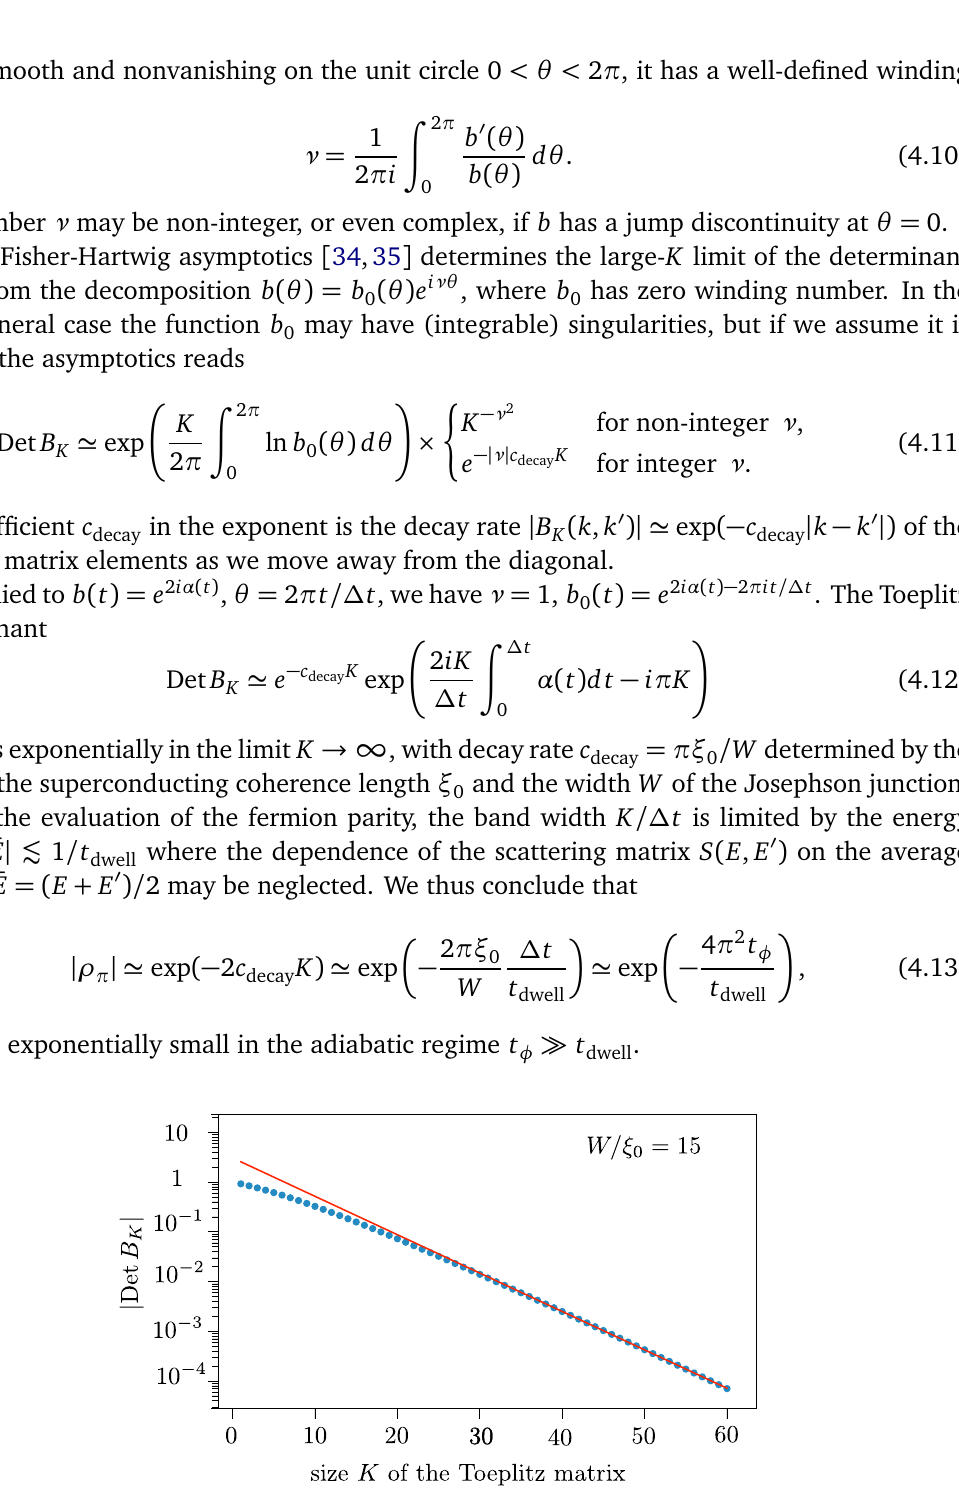
Figure 4: Decay of the Toeplitz determinant compared with the exponential decay expected from Eq. (4.12). The data points are calculated directly from Eq. (4.9) with b ( θ ) = exp [ 2 i α ( t )] , θ ≡ φ = 2 π t / ∆ t , given by Eq. (4.2) for W /ξ constant c was calculated separately from | B decay = πξ / W is off by estimate c decay 0